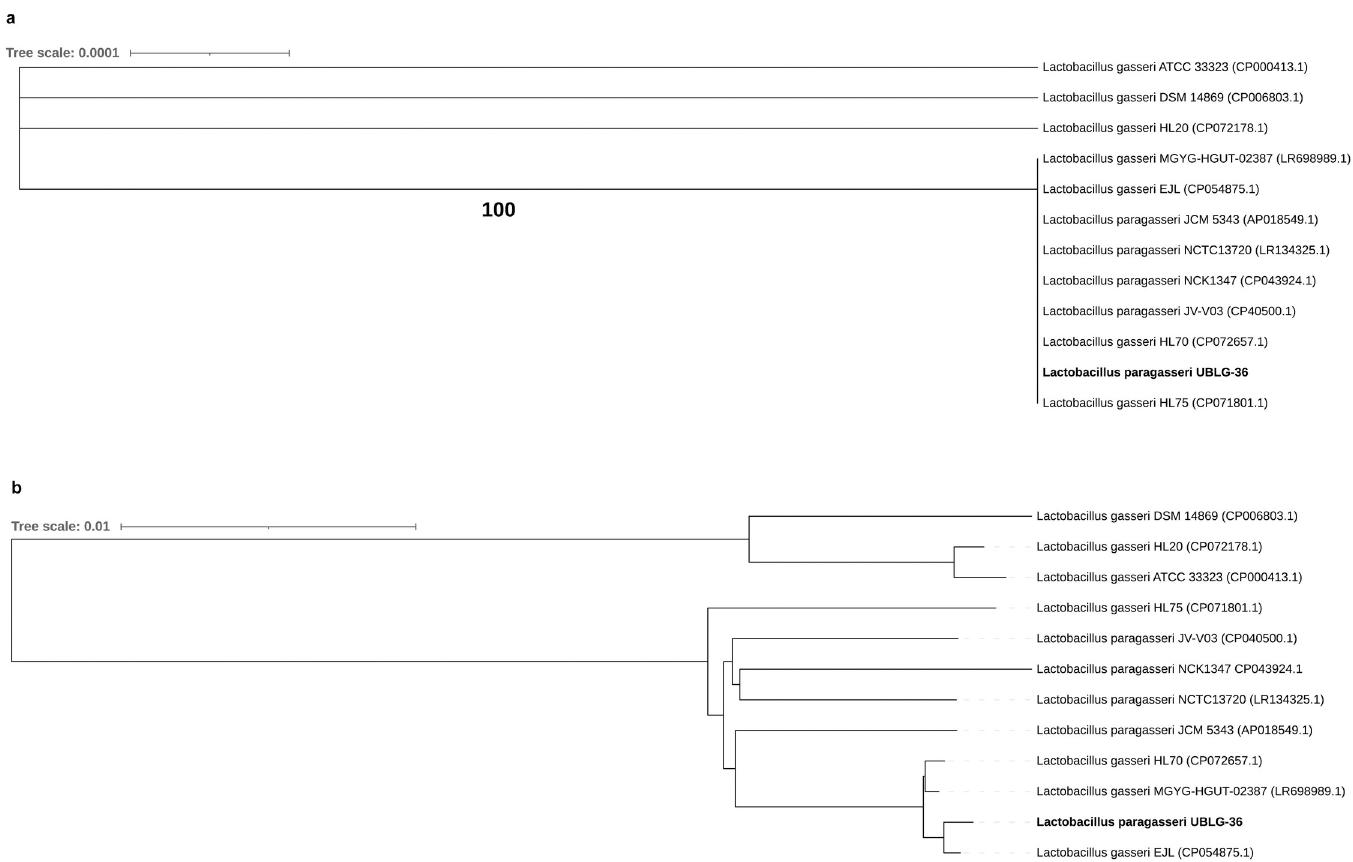
Fig 1. Phylogenomic analysis of Lactobacillus paragasseri UBLG-36. (a) Phylogenetic relationship between Lactobacillus paragasseri UBLG-36 and other L . gasseri and L . paragasseri strains. Phylogenetic tree construction was based on the pairwise sequence similarities of the 16S rDNA sequences mined from the complete representative genome sequences and draft genome sequence of UBLG-36. Tree calculation and inference were carried out on the TYGS web server (http://tygs.dsmz.de/). L . paragasseri UBLG-36 is depicted in bold. (b) Phylogenomic comparison of Lactobacillus paragasseri UBLG-36 with representative complete genomes of other L . gasseri and L . paragasseri strains. A pairwise comparison of the whole genomes was carried out on the TYGS web server, and the tree was inferred from GBDP distances calculated from the genome sequences. L . paragasseri UBLG-36 is depicted in bold. https://doi.org/10.1371/journal.pone.0260116.g001 covering a total length of 1,941,907 bp, with a G + C content of 34.85% and an N 50 of 77,703 bp (Table 2). Annotation of the draft genome using the NCBI PGAP predicted a total of 1918